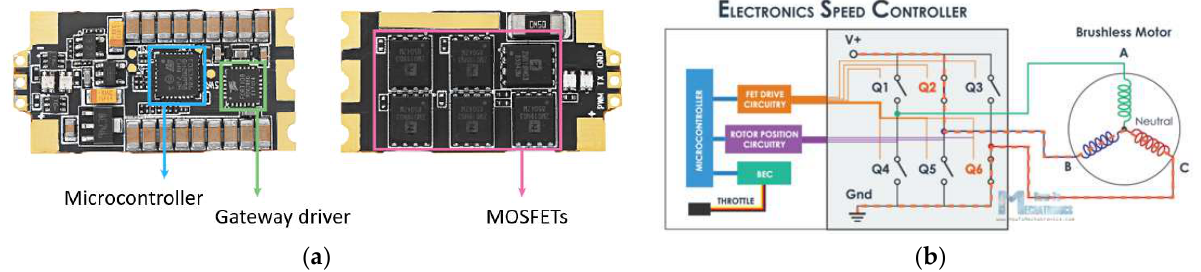
Figure 10. The ESC architecture and simplified diagram of ESC operation. ( a ) ESC general architecture; ( b ) Simplified diagram of ESC operation.